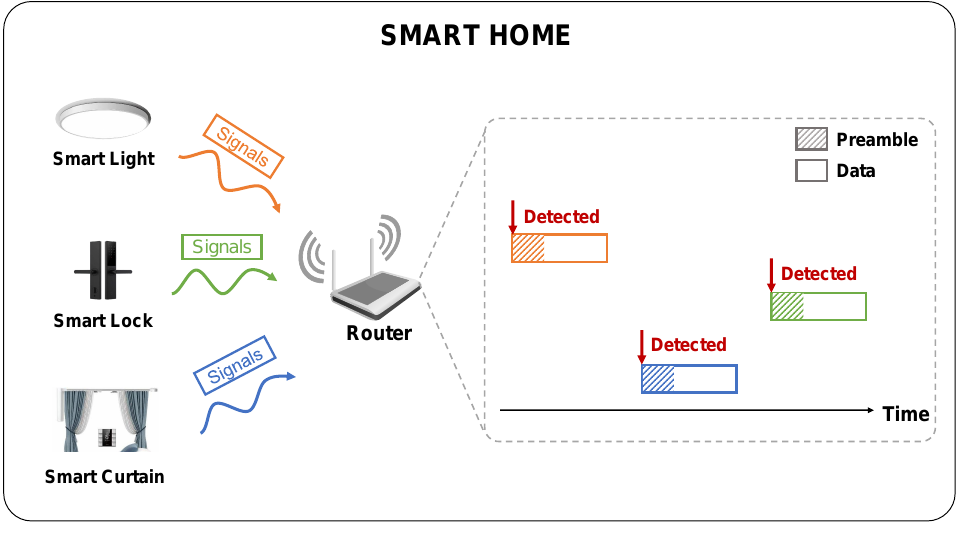
Figure 1. Packet detection is a key technology for smart household wireless communication